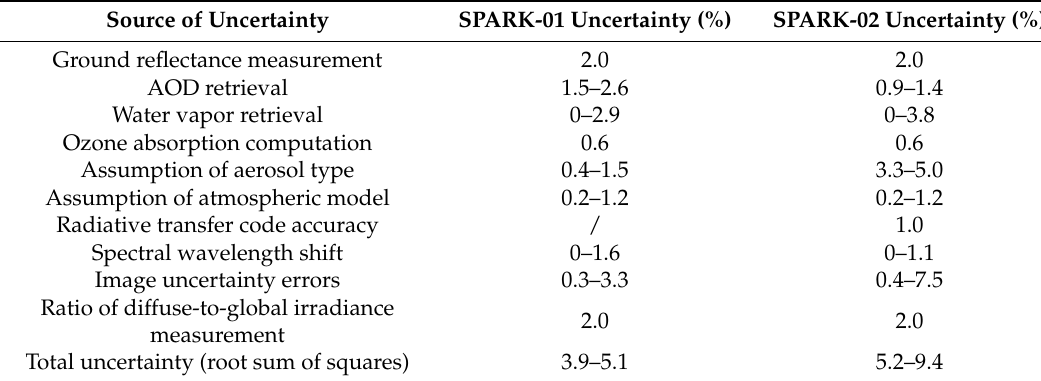
Table 6. Estimated uncertainty associated with the irradiance-based method used for SPARK-01 and the improved irradiance-based method used for SPARK-02.